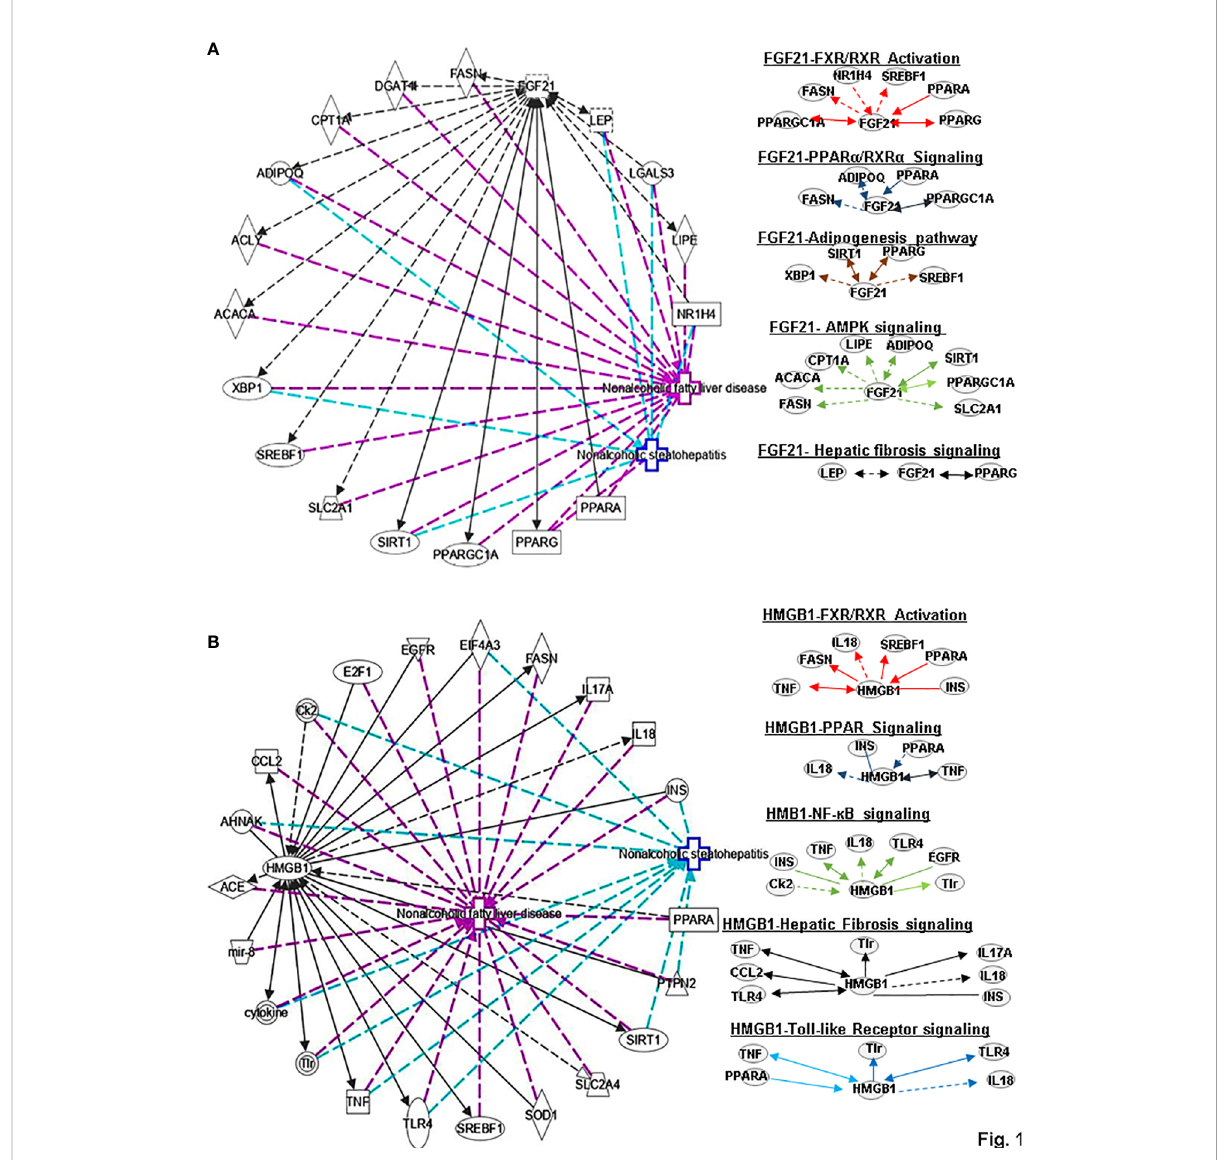
FIGURE 1 Ingenuity pathway analysis (IPA) of FGF21 and HMGB1. (A) IPA investigated the molecular pathways of FGF21 involved in NAFLD and NASH using the website: www.ingenuity.com. Purple lines show these genes and molecules are related to NAFLD. Green lines show these genes and molecules are associated with NASH (left). All identi fi ed pathways of FGF21 were screened individually. Representative canonical pathways of FGF21 are associated with other related genes (including the transcription regulator and enzymes, et al) and molecules of NAFLD and NASH. Functional relationships of these genes, molecules and FGF21 are depicted using straight lines with arrows. FGF21 is functionally related to 1. FXR/RXR signaling; 2. PPAR a /RXR a signaling; 3. Adipogenesis signaling; 4. AMPK signaling and 5. Hepatic fi brosis signaling (Right). (B) IPA investigated the molecular pathways of HMGB1 involved in NAFLD and NASH. All identi fi ed pathways of HMGB1 were screened individually (left). Representative canonical pathways of HMGB1 are associated with other related genes and molecules of NAFLD and NASH. Functional relationships of these genes and HMGB1 are depicted using straight lines with arrows. HMGB1 is functionally related to: 1. FXR/RXR signaling; 2. PPAR signaling; 3. NF- k B signaling; 4. Hepatic fi brosis signaling and 5. Toll-like Receptor signaling (Right). Solid lines show direct regulation while dotted lines depict indirect interactions. PPARGC1A, PPARG Coactivator 1 Alpha; FASN, Fatty Acid Synthase; NR1H4, Nuclear Receptor Subfamily 1 Group H Member 4; SREBF1, Sterol regulatory element-binding transcription factor 1; PPARA, Peroxisome Proliferator Activated Receptor Alpha; PPARG, Peroxisome proliferator- activated receptor gamma; ADIPOQ, Adiponectin; XBP1, X-Box Binding Protein 1; SIRT1, Sirtuin 1;ACACA, Acetyl-CoA Carboxylase Alpha; CPT1A, Carnitine Palmitoyl transferase 1A; LIPE, Lipase E; SLC2A1, Solute Carrier Family 2 Member 1, LEP, Leptin; IL-18, Interleukin 18; INS, Insulin; TNF, Tumor necrosis factor; Ck2, Casein kinase II; TLR4, Toll like receptor 4; EGFR, Epidermal growth factor receptor; TIr, Toll/interleukin-1 receptor-like protein; CCL2, C-C Motif chemokine ligand 2; IL-17A, Interleukin